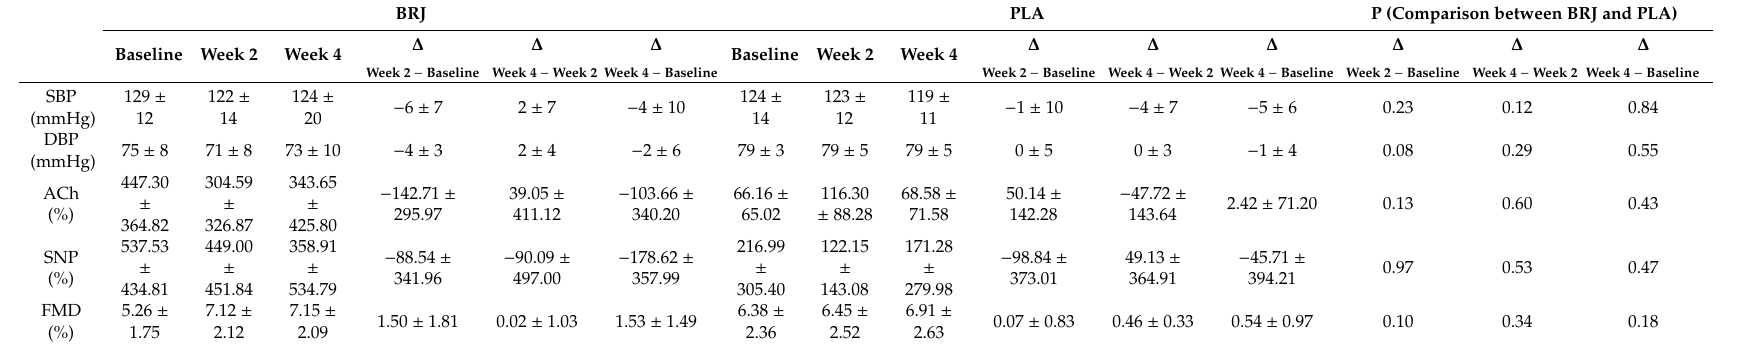
Table 2. Changes in vascular outcomes during the